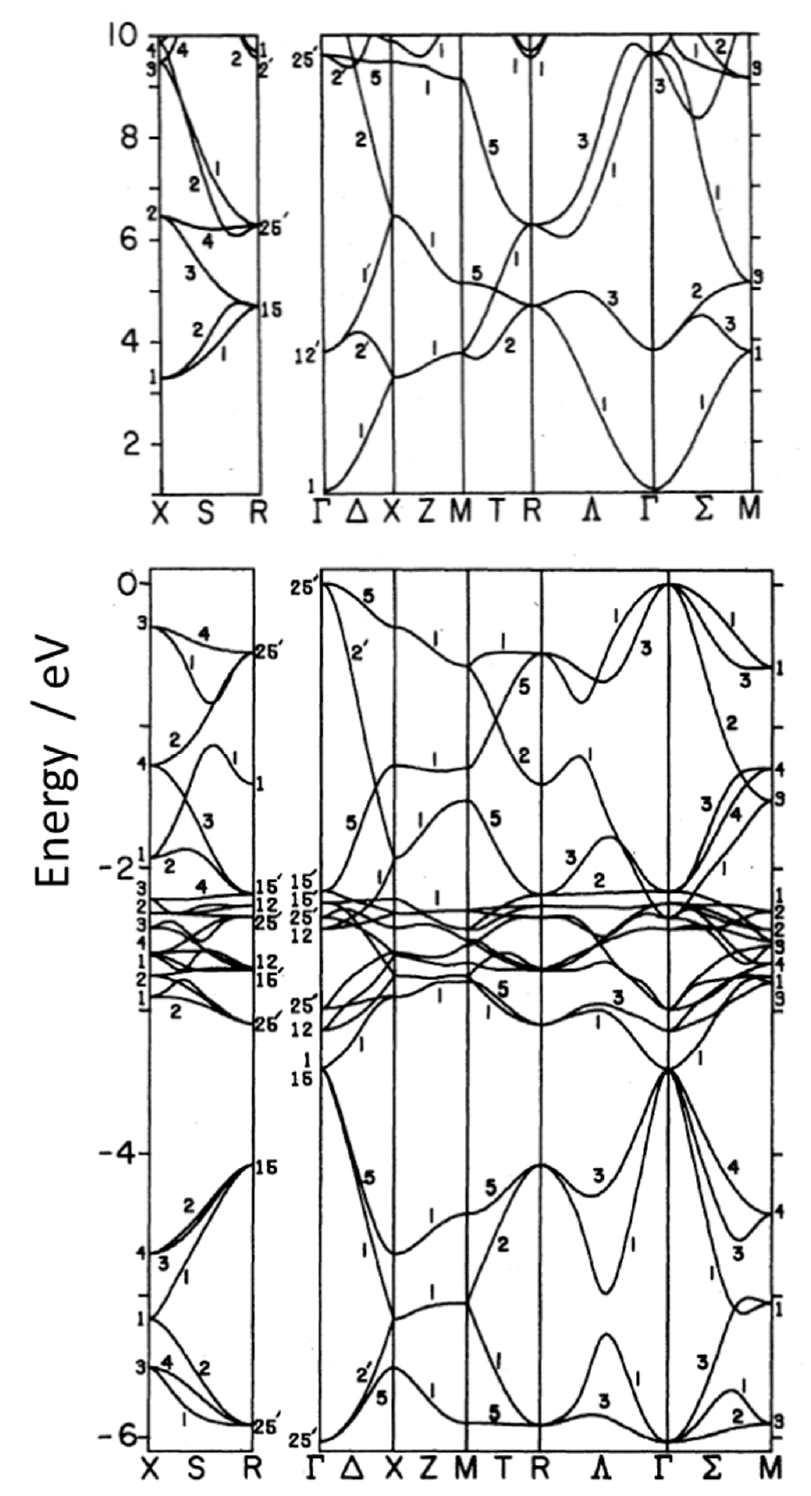
Figure 9. Cu 2 O band structure plot calculated with the LDA self-consistent method. On the top, conduction band; on the bottom, valence band. Reprinted from [93] with the permission of the American Physical Society.